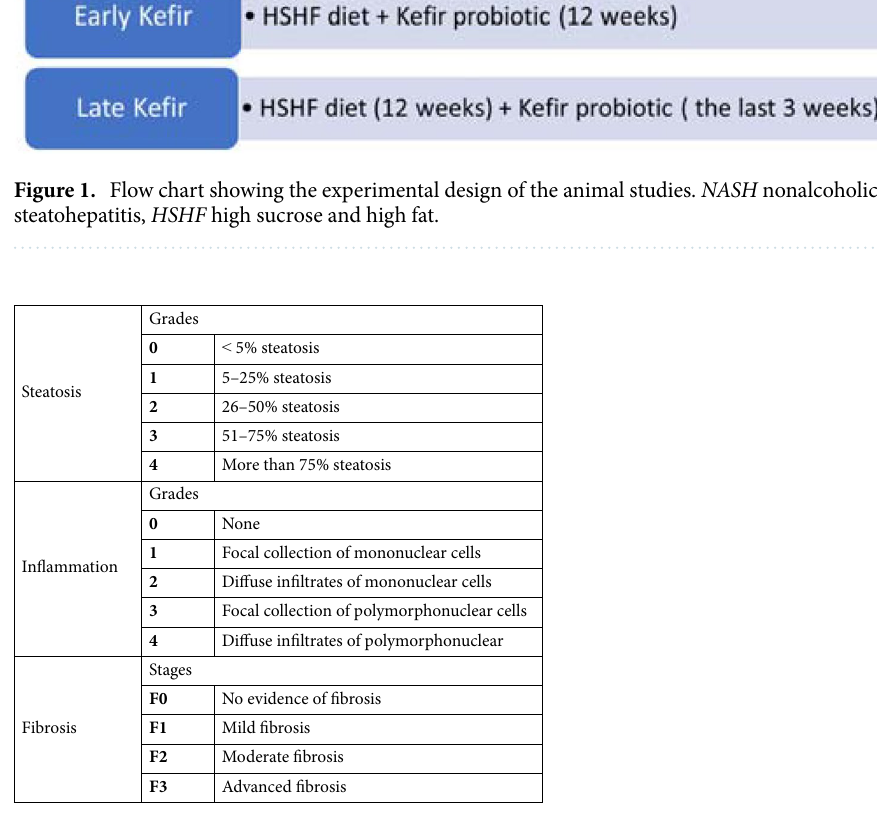
Table 1. Histological grading of steatosis, inflammation and staging of fibrosis.